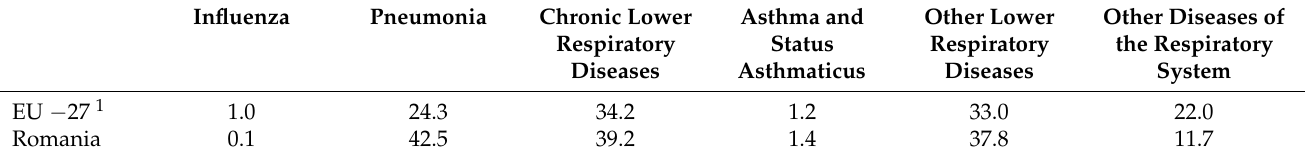
Table 1. Standardized death rates—respiratory disease